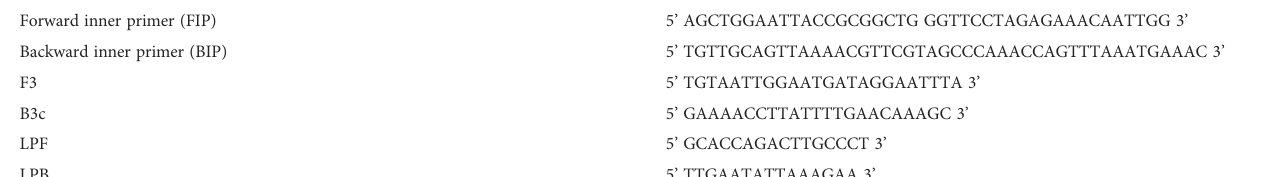
TABLE 1 List of LAMP primers